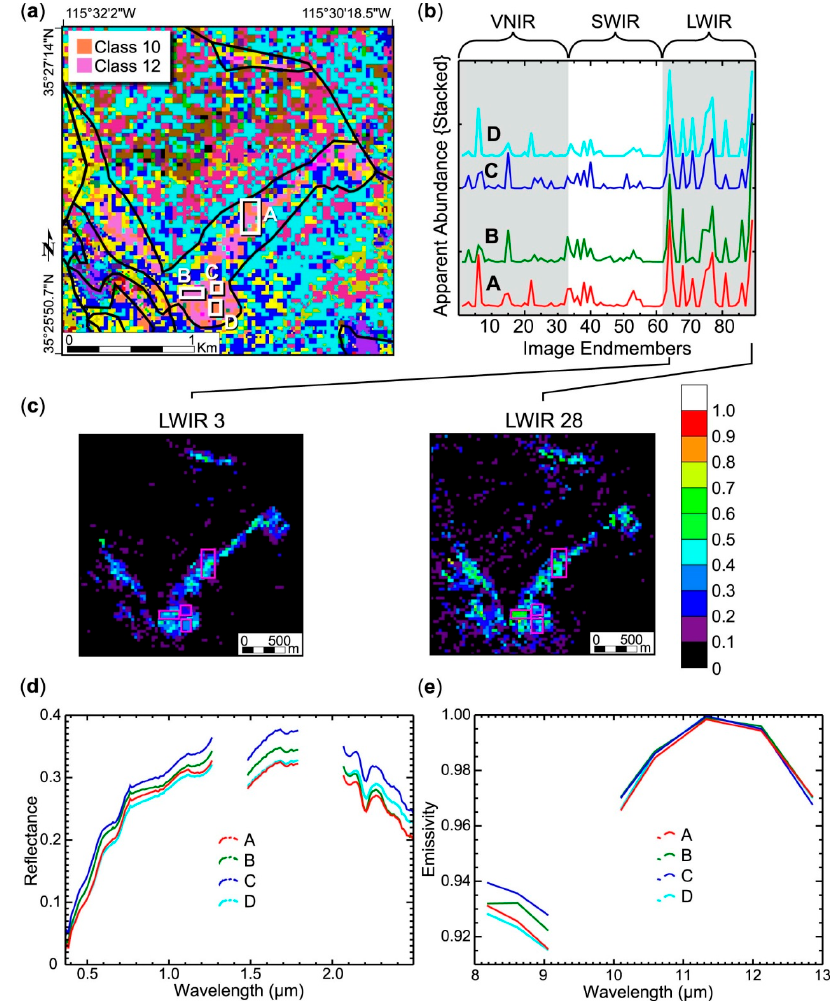
Figure 14. Examination of individual wavelength range results incorporated in the full-range characterization of a quartz-rich sandstone unit: ( a ) subset of the integrated classification map with outlines of general surface units and regions of interest corresponding to subsequent plots; ( b ) graph of mean endmember abundance values for selected regions of interest, offset for clarity; ( c ) abundance distribution images for notable endmembers; ( d ) mean visible to near infrared (VNIR) and shortwave infrared (SWIR) spectra of selected regions of interest; ( e ) mean longwave infrared (LWIR) spectra of selected regions of interest.